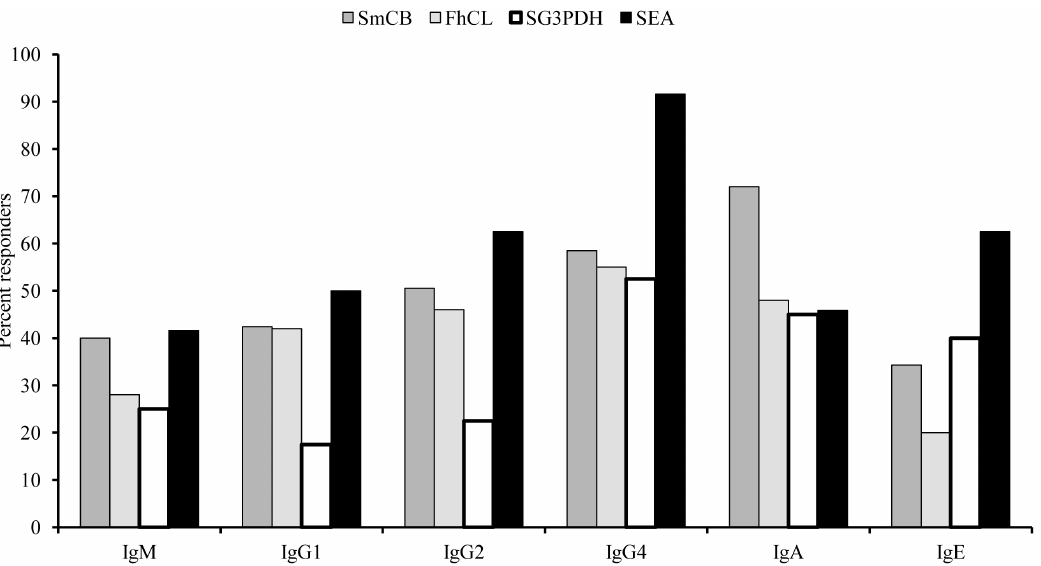
Figure 4. Human antibody isotype responses. A total of 50 patients (18–20 year-old) with confirmed schistosomiasis (100–400 eggs/gram stool) were tested for serum antibody IgM, IgG1, IgG2 (sera diluted 1:250), IgG4, IgA1/A2, and IgE (sera diluted 1:25) reactivity to recombinant SmCB, FhCL, or SG3PDH (250 ng/well), or SEA (1 m g/well) in duplicate wells. Patients with mean absorbance values higher than the mean absorbance values of 14 sex- and age-matched, parasite-free, control donors are considered